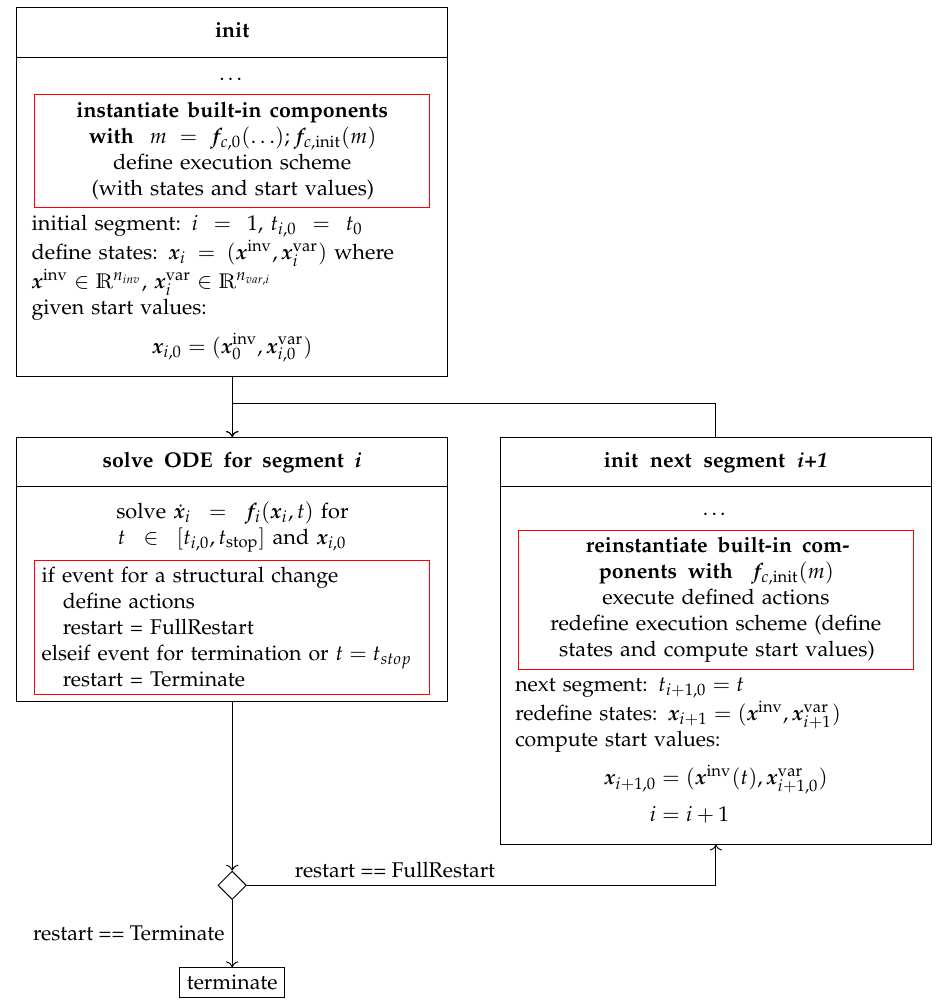
Figure 7. State machine of the segmented simulation as used by